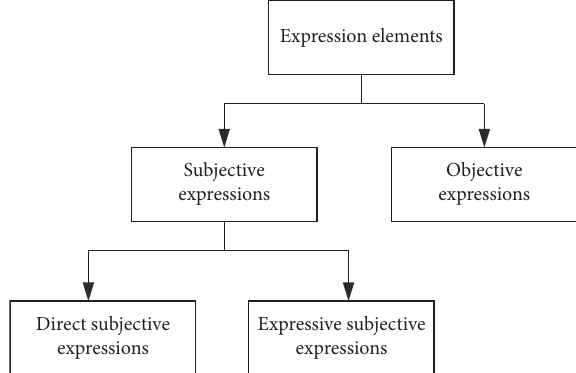
Figure 1: Schematic diagram of expressive elements